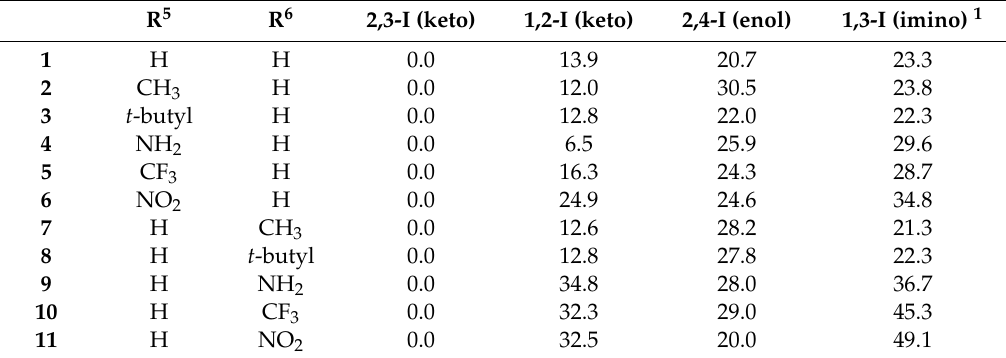
Table 1. The relative energies (kJ / mol) of four tautomers of compounds 1 – 11 (Figure 2) calculated at the B3LYP / 6-311 ++ G(2df,2pd)